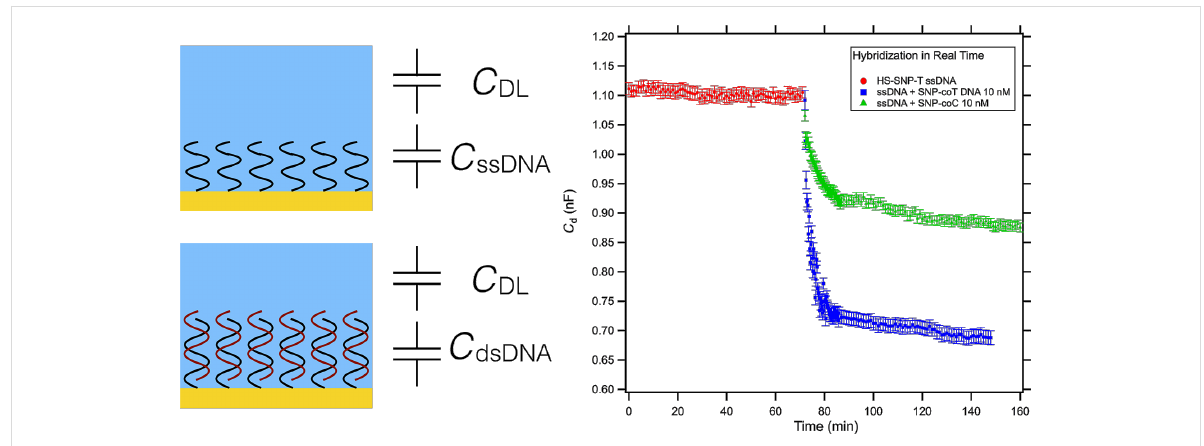
Figure 3: Schematic representation of the electrode/electrolyte interface. The first layer in contact with the gold electrode is the ssDNA self-assem- bled monolayer, modelled as a capacitance C ssDNA . Then we have the ions present in solution that arrange in response to the gold and DNA charges forming the so-called double layer capacitance C DL , in series with C ssDNA . When hybridization occurs, the binding of the complementary strand will produce a change in capacitance due to height changes, substitution of water molecules in the biological layer, and changes in the electrical charge density. The capacitance, extracted from the impedance measured in our electrochemical setup, is plotted versus time for the ssDNA-functionalized electrode (red curve) and for the mismatched (green) and perfectly matching (blue) complementary